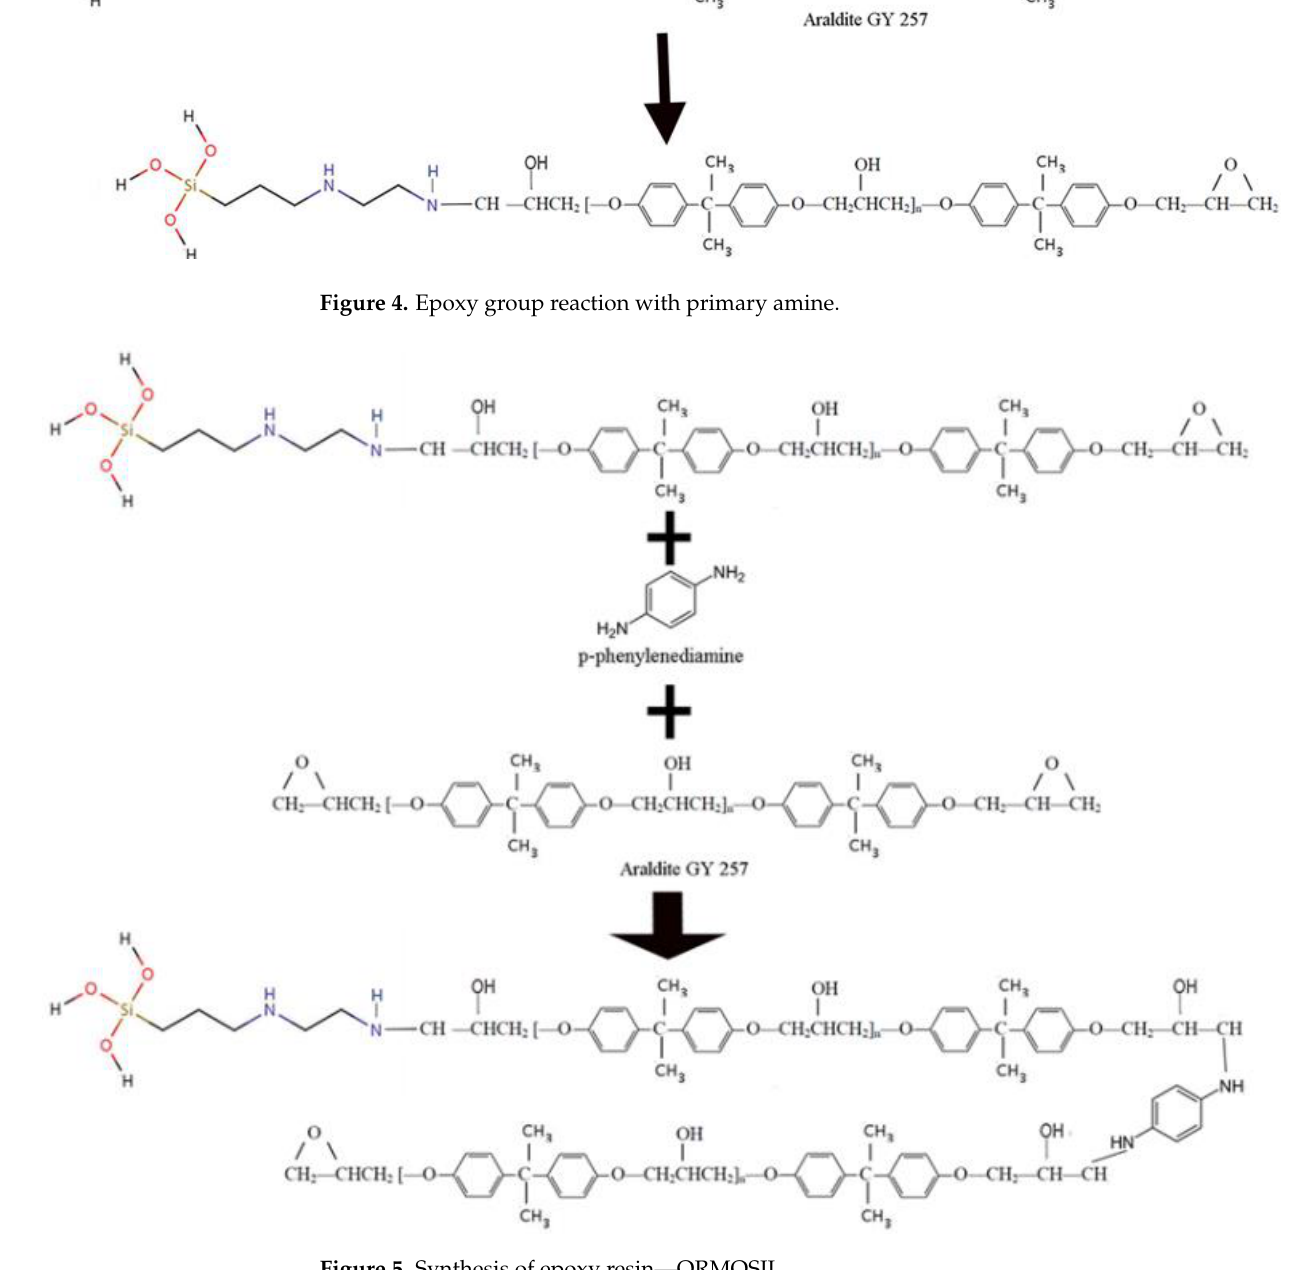
Figure 5. Synthesis of epoxy resin — ORMOSIL.